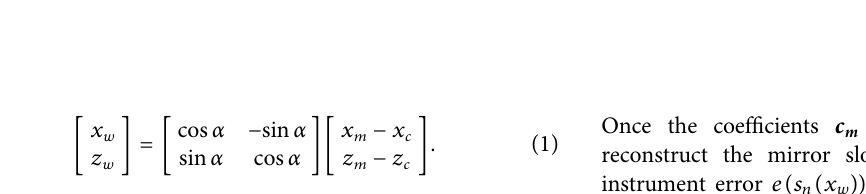
FIGURE2| Theworldcoordinatesystem ( X w , Z w ) andthemirrorcoordinatesystem ( X m , Z m ) de fi nedinthemulti-pitchNSPtechniquewhenthepitchangle α (cid:2) 0 (A) and α ≠ 0 (B)